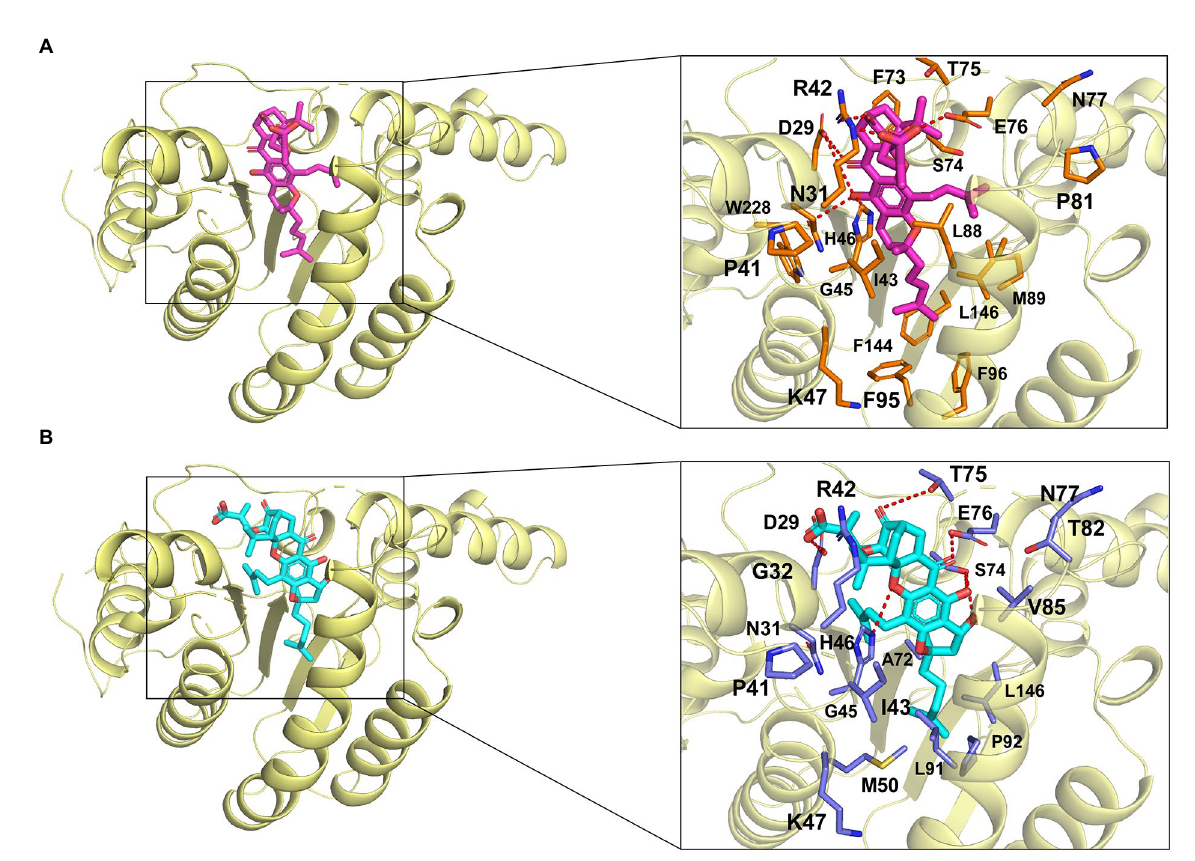
FIGURE 5 Simulated molecular interactions between GA/NGA and Efa UPPS. (A,B) Overall structure of Efa UPPS enzyme in complex with GA (purple, A ) or NGA (cyan, B ). The close-up views of simulated GA/NGA- Efa UPPS interactions in the binding pocket are highlighted in black boxes: red stick, oxygen atom; blue stick, nitrogen